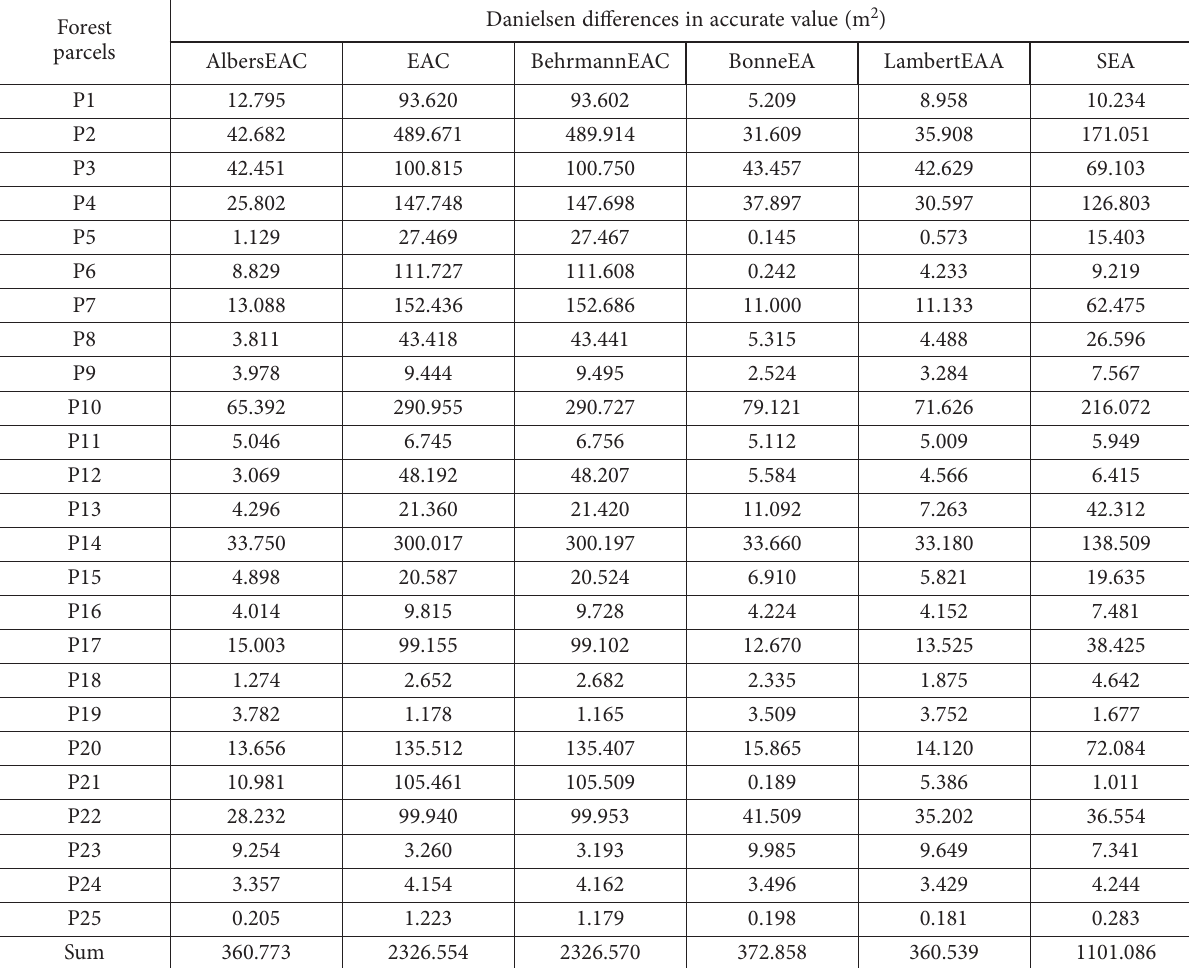
Table 3 was used to determine the area-preserving projec- tion that achieved the minimum area deformation value.